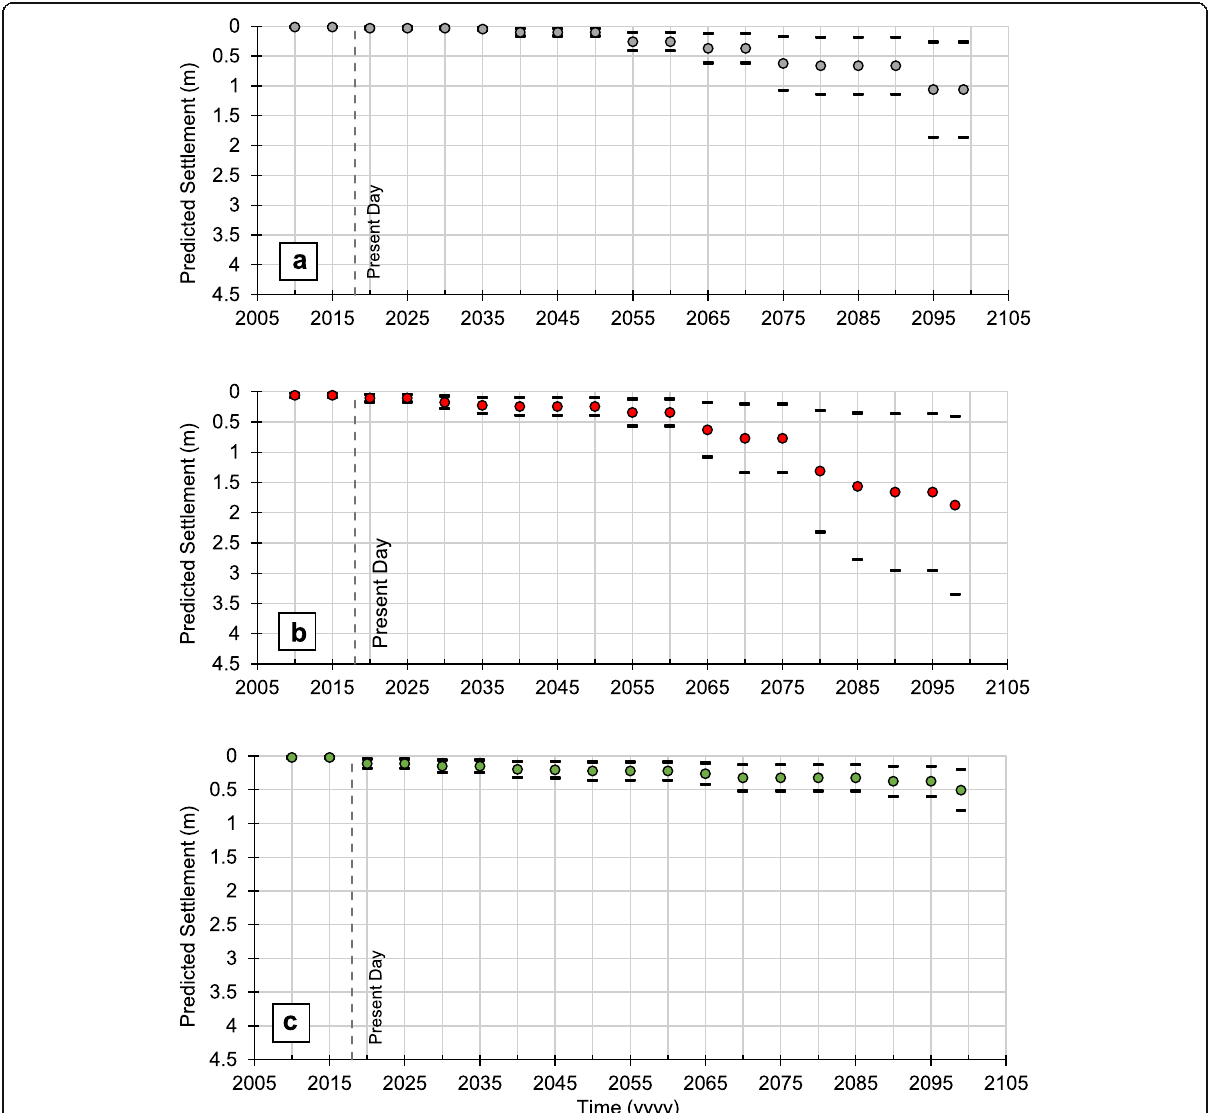
Fig. 12 Predicted settlement at the study site due to active layer thickening under undisturbed ground surface conditions: a 28 Climate Model Average; b BNU-ESM upper bound climate model; c CMCC-CESM lower bound climate model. The dashed vertical line at 2018 indicates the present day for